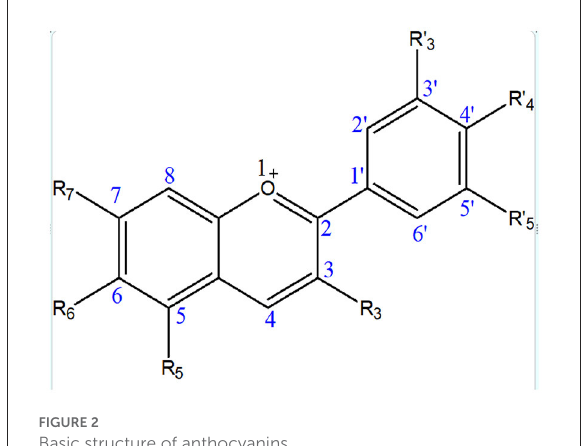
FIGURE2 Basic structure of